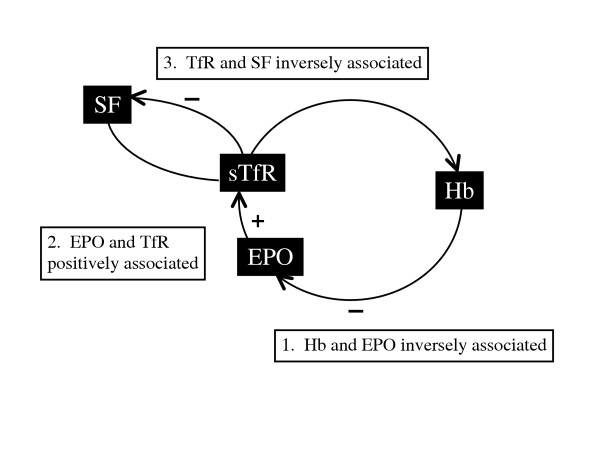
Model of the relationships between indicators or iron status and erythropoiesis. The model is based on the assumptions that hypoxia determines EPO production which in turn stimulates erythropoietic activity that drives the need for iron and corrects the hypoxia. Abbreviations: Hb, hemoglobin; EPO, erythropoietin; TfR, transferrin receptor; SF, serum ferritin.